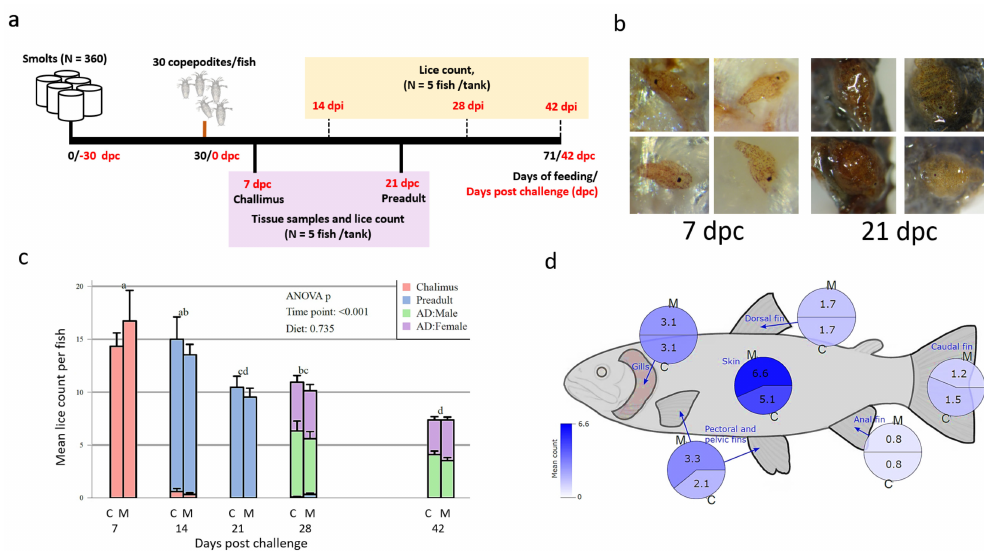
Figure 1. Experimental design and lice count ( a ) Experimental design. ( b ) Lice samples with chalimus (7 dpc) and preadult lice prior (21 dpc) to RNA extraction ( c ) Mean lice count (separated for the developmental stage of the lice) per fish at days post-challenge (dpc) for the two feeding groups. Two-way ANOVA for time points and diet, followed by Tukey post hoc test to identify differences between time points. Bars which do not share a letter are significantly different ( p < 0.05) to each other. ( d ) Mean lice numbers at different body positions at 7 dpc, represented as pie charts for the two feeding groups. Colors from white to blue represent the scale from 0 to 6.6 (the maximum) lice per fish, for C and M